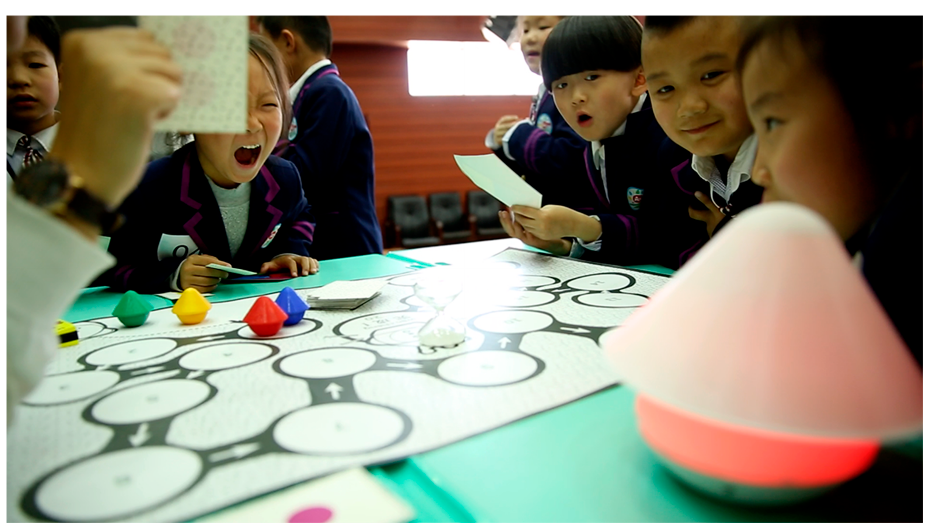
Figure 2. A still-frame from the playtest with Shybo at the primary school, in Yuncheng, China. Setting and Materials